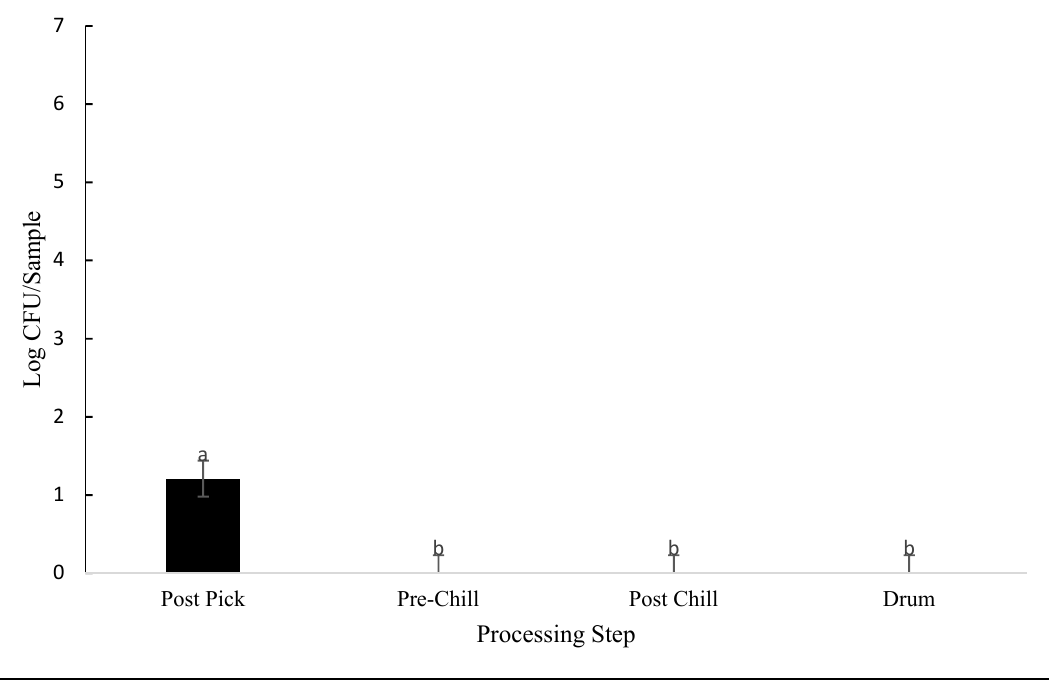
Figure 5. Pseudomonas contamination expressed as log CFU/sample, detected from samples collected at post ‐ pick, pre ‐ chill, post ‐ chill, and drumsticks ( p = 0.001). Means with different letters differ statistically.